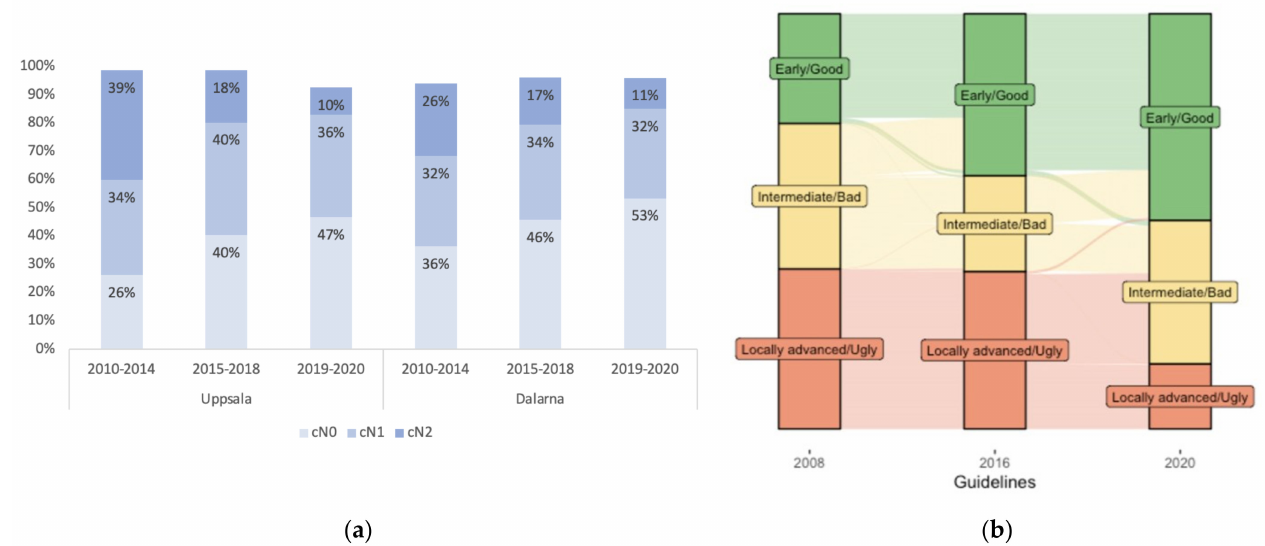
Figure 2. ( a ) Distribution of cN-stage for the time periods during which different treatment guidelines were used (2008 guidelines in 2010–2014, 2016 guidelines in 2015–2018 and 2020 guidelines in 2019– 2020) in Uppsala and Dalarna regions. The columns do not add up to 100% since nodal status was not detailed in all patients. The changes in cN positivity for each year is shown in Figure S4; ( b ) Distribution of risk groups in an alluvial diagram after re-classifying all tumours (that had all necessary data available, n = 1038) according to the different guidelines. With the 2008 guidelines, there was an even distribution of the three risk groups; 26% of the tumours were classified as early/good, 36% intermediate/bad and 38% locally advanced/ugly. With the 2016 guidelines, the number of bad tumours decreased while the number of ugly tumours stayed virtually the same; 38% good, 24% bad and 37% ugly. Major changes in the 2020 guidelines meant that even more tumours should be considered good, and more than half of the ugly tumours should now be considered bad; 50% good, 35% bad and 15%